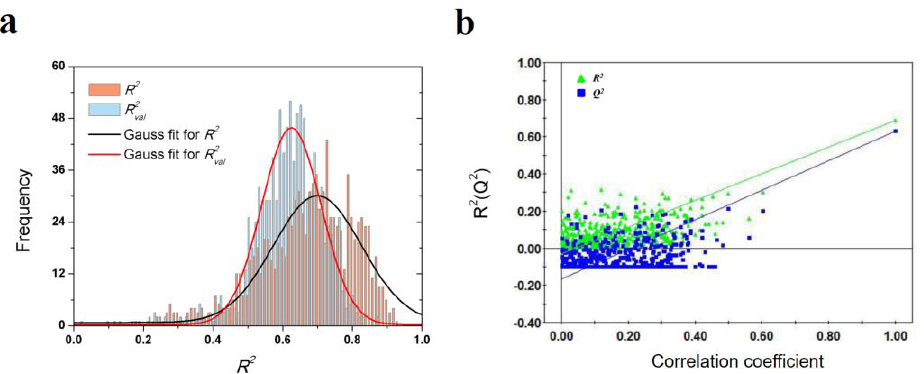
Figure 4. Results of PLS model validations. ( a ) frequency distribution of R 2 and R 2 val in 1000-times repeated PLS modeling; ( b ) 500-times Y random permutation test.